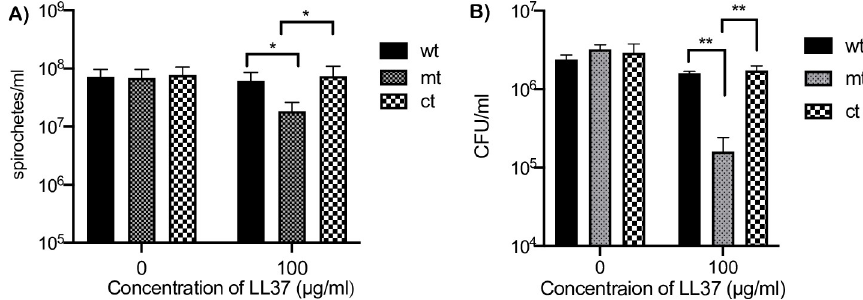
Fig 13. Sensitivity of bpiP mt to human antimicrobial peptides. All three strains (wt, mt and ct) were propagated at 10 5 /ml in BSKII growth medium at pH 6.8/32˚C with 0 or 100 μ g/ml LL37. (A) Spirochetes were enumerated every 24 hours and data shown is for the number of spirochetes/ml after 5 days of treatment. ( B ) Colony forming units of cultures with 0 or 100 μ g/ml of LL37 were determined by diluting cultures of all three strains to 1:100,000 in 1X BSKII medium, plated on BSKII agar overlays and the final CFU/ml of the treated cultures were calculated after 10 days of incubation at 32˚C with 1% CO 2 . The cultures were grown in triplicate and one out of two independent experiments is shown. Statistical analysis of the difference in the number of wt and mt or ct and mt spirochetes was done by unpaired t test. The asterisks indicate levels of significance as follows: �� , p < 0.01; � , p <